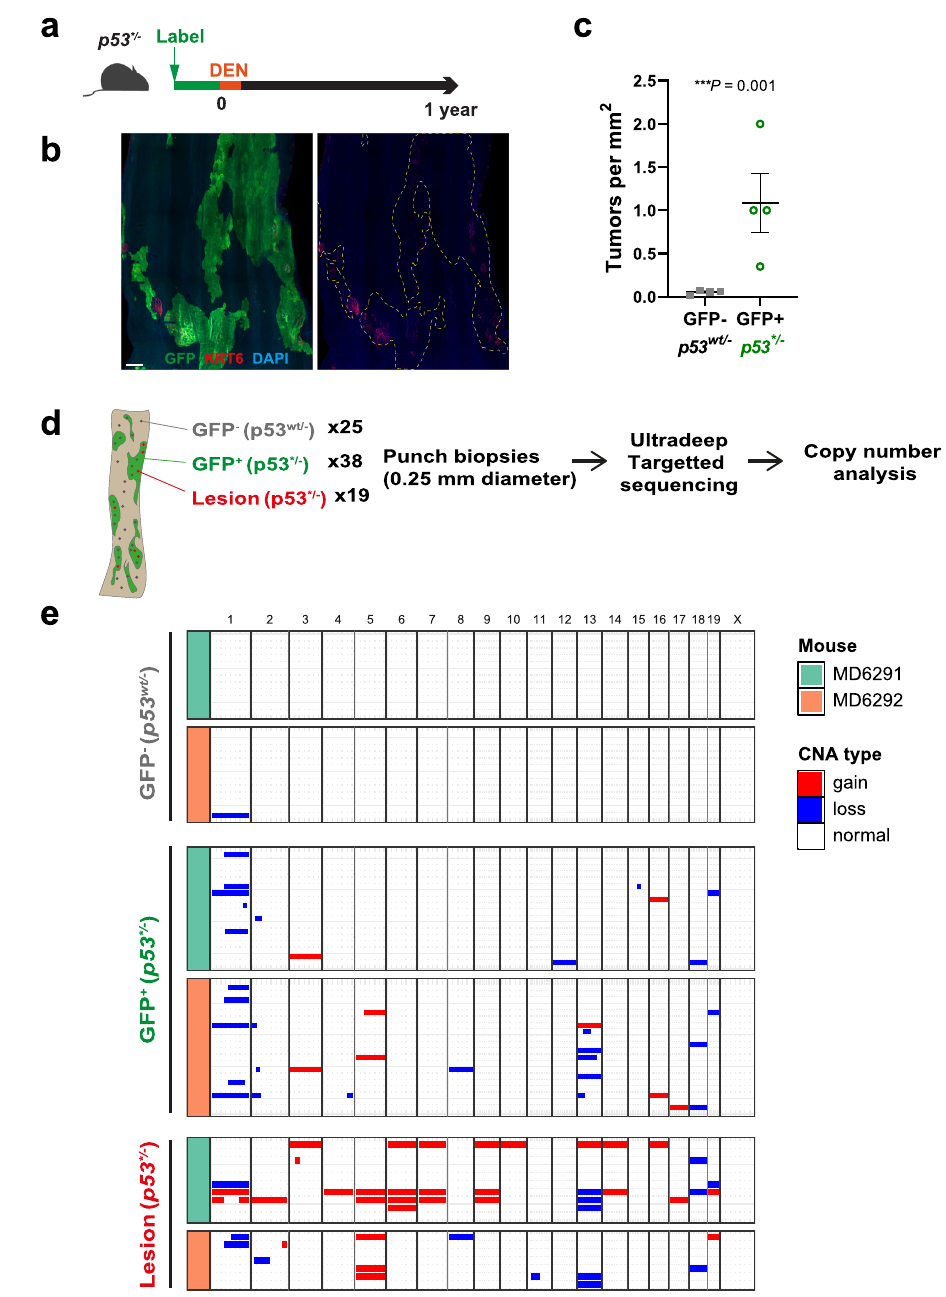
Fig. 6 | Effect of mutagenesis and aging p53 */ − epithelium. a Protocol: Induced p53 */ − mice were treated with DEN for 2 weeks and aged. b Confocal image of p53 */ − inducedepitheliumat1yearpostDENtreatment.Typicalexamplefrom n =4mice. Green, GFP; red, KRT6; blue, DAPI. Scale bar, 400 µ m. c Number of tumoursfound in p53 */ − (GFP+) and p53 wt/ − (GFP − ) area. Error bars are mean ± s.e.m. n =4 mice, p value was determined by two-tailed ratio paired t-test. d Sequencing analysis of DENtreated p53 */ − epitheliumat1yeartimepoint.Micro-punchbiopsiesweretaken